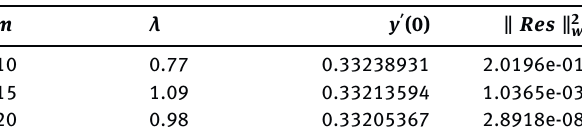
Table 9: Obtained values of y ′′ (0) by the present method for various values of m and α = 0.50